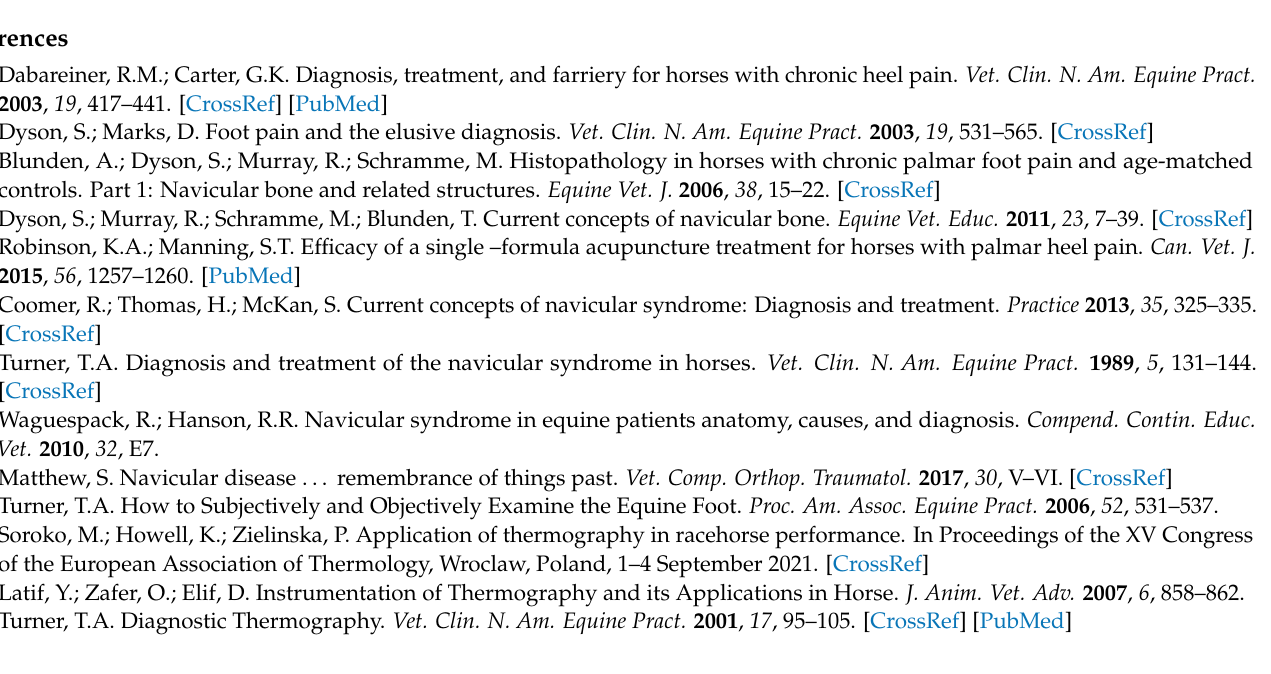
ROC curve frog area; Figure S3: ROC curve toe area; Tables S1–S6—Thermography results–Temperature for toe (El2) and frog (El1)